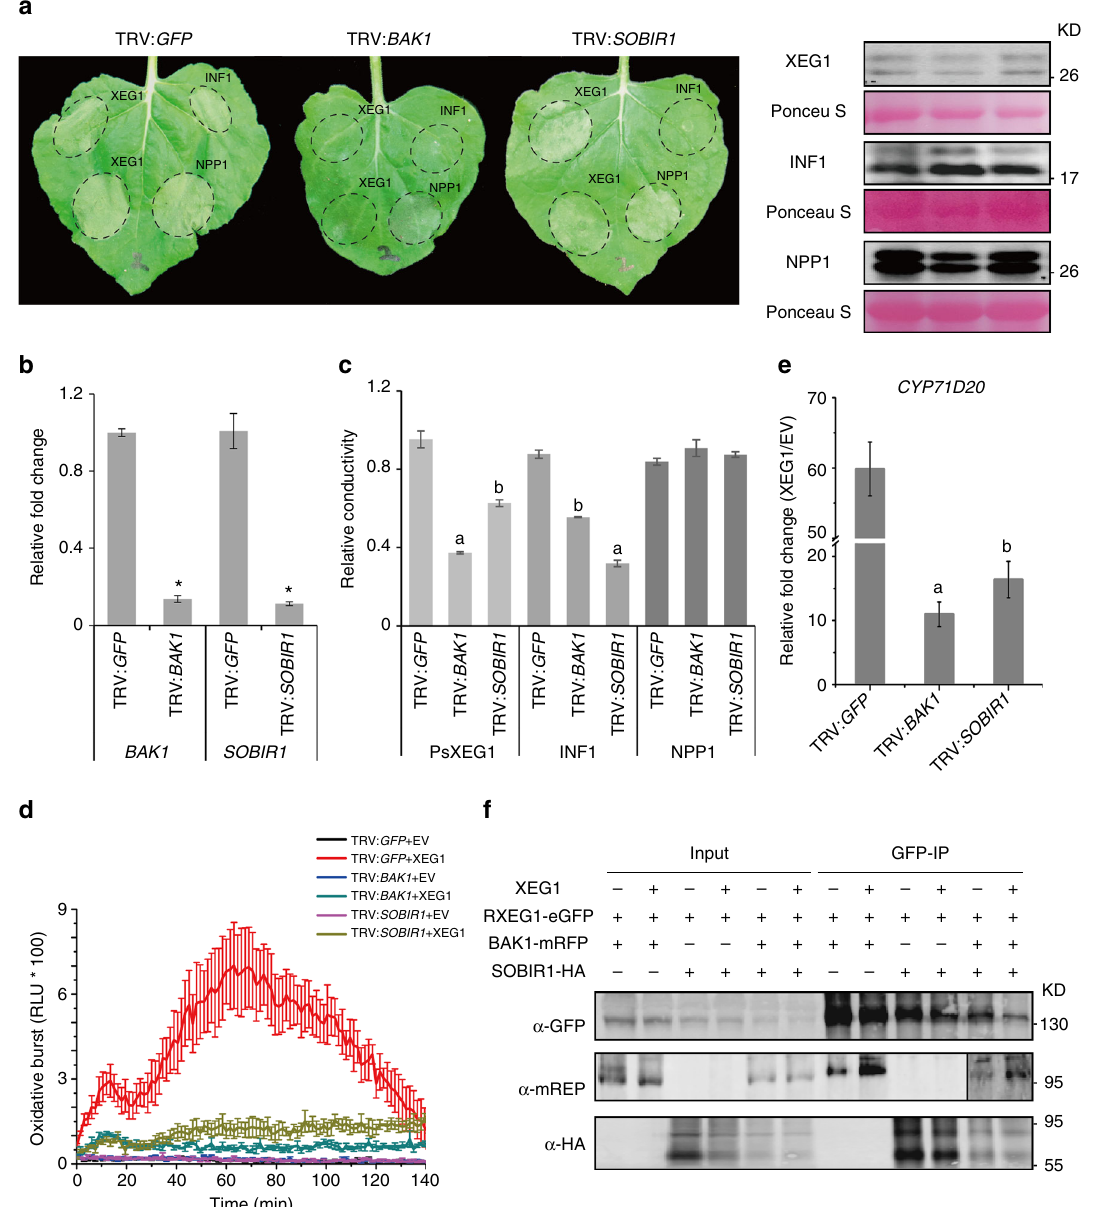
Fig. 6 BAK1 and SOBIR1 associate with RXEG1 and are required for RXEG1-mediated XEG1 recognition. a Representative leaves showing cell death induced by expression of XEG1, INF1, or NPP1 in N . benthamiana leaves treated with TRV: GFP , TRV: BAK1 , or TRV: SOBIR1 . XEG1, INF1, and NPP1 were transiently expressed in N . benthamiana . In fi ltrated leaves ( n = 6) were photographed at 3 dai. Protein expression at 2 dai was monitored by western blotting with anti- HA antibody. Protein loading is indicated by Ponceau S staining. Experiments were repeated at least three times with similar results. b Silencing ef fi ciency of BAK1 and SOBIR1 in N . benthamiana . The transcript levels were monitored by qRT-PCR, normalized with EF-1 α , and expressed as mean fold changes ( ± s.e. m.) relative to TRV: GFP -treated leaves, which was set as 1. * indicates signi fi cant differences ( P < 0.01, Student ’ s t -test) in expression level when